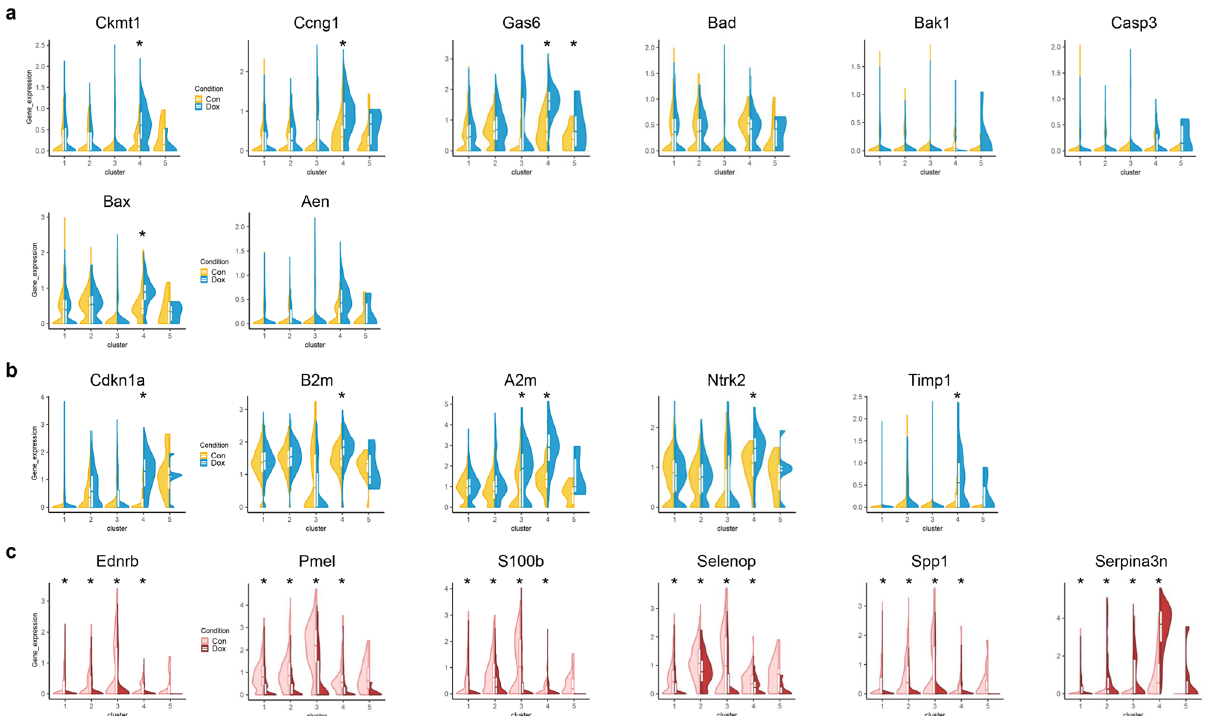
Fig. 4 Dox treatment-induced DEGs are associated with apoptosis/senescence in a speci fi c cluster while 6 genes are changed in all clusters. a Violin plots of genes associated with the regulation of apoptosis. b Violin plots of the genes associated with cellular senescence. c Violin plots of the genes that showed signi fi cant changes in expression in all 5 clusters. The X -axes depict the cell cluster number, and the Y -axes represent the expression of each gene. The statistical signi fi cance of differences in expression between control and Dox-treated RPE cells is indicated as an asterisk on the corresponding cluster based on the p values of the corresponding Wilcoxon rank sum tests.